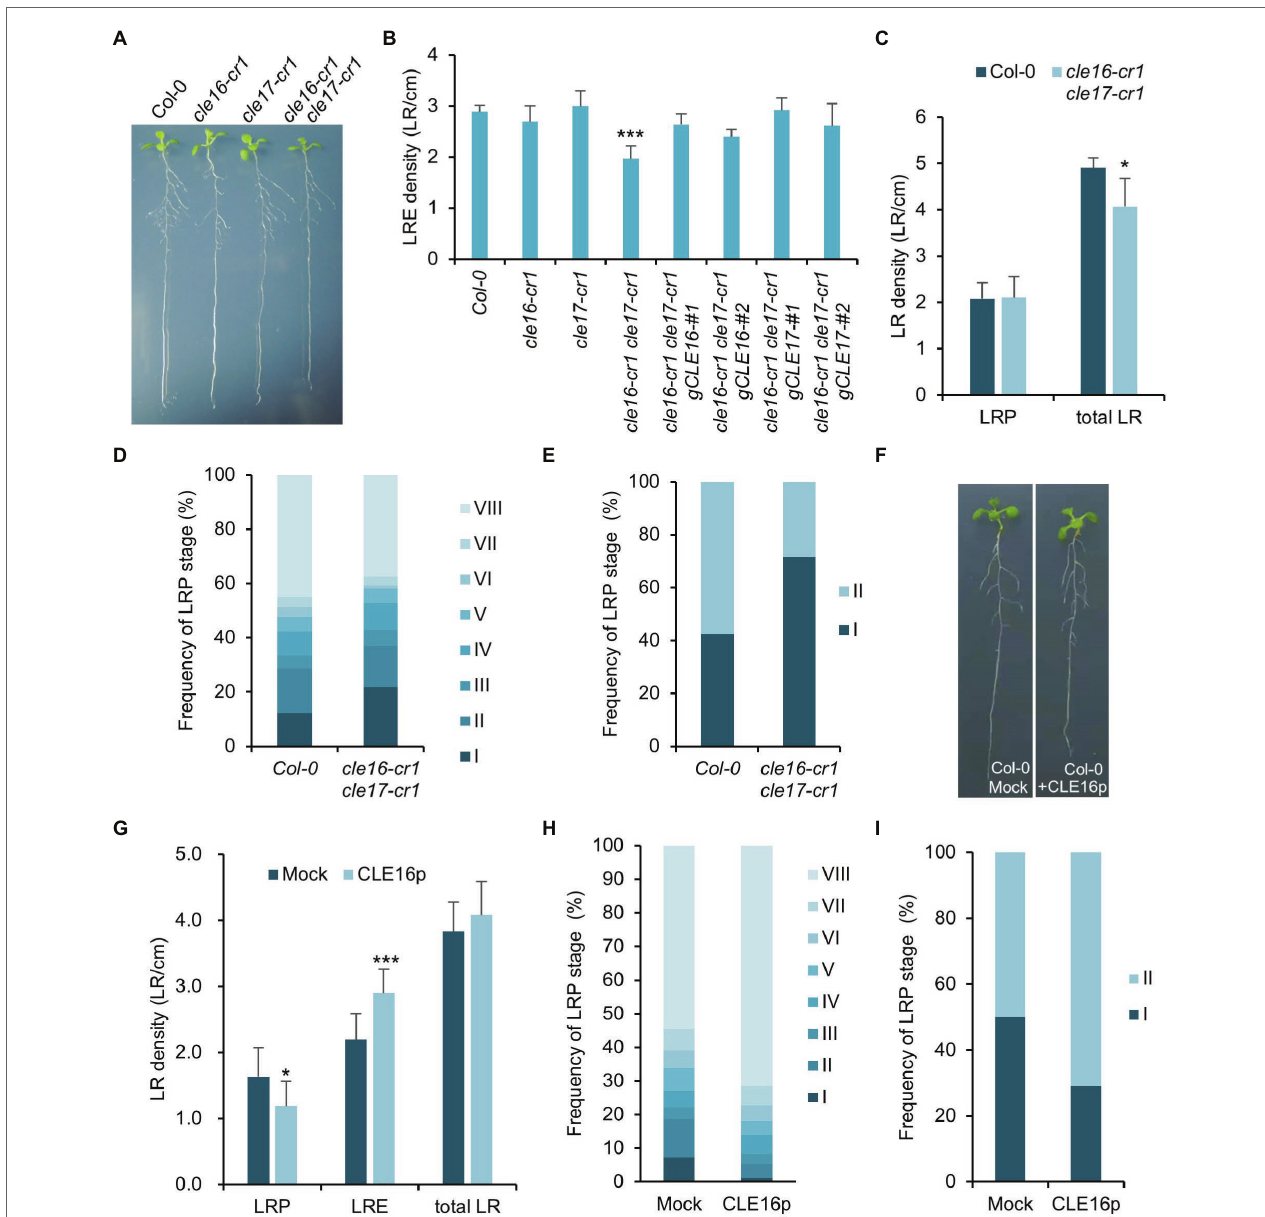
FIGURE 5 | CLE16/17 are required for lateral root emergence. (A) Phenotypes of the seedlings of cle16/17 double mutants at 8 dpg. (B) Quantification of lateral root emergence (LRE) density in the cle16/17 double mutants. n = 30 for each genotype. (C) LR primordia (LRP) and total LR (LRE + LRP) density of wild-type (Col-0) and cle16/17 at 8 dpg. n = 35 for each genotype. (D) Quantification of LRP at various stages in Col-0 and cle16/17 . Stages I–VIII are color-coded. n = 30 for each genotype. (E) Quantification of the initiated LRP at stage I or II in Col-0 and cle16/17 after primary root bending for 18 h. n = 30 for each genotype. (F) Seedlings of Col-0 at 8 dpg after mock or 1 μ M CLE16p treatment for 2 days. (G–I) Quantification of LRP, LRE, and total LR density in seedlings treated with or without 1 μ M CLE16p. (H) Quantification of individual primordia stages in seedlings treated with or without CLE16p. (I) Quantification of the initiated LRP at stage I or II in Col-0 treated with or without CLE16p after primary root bending for 18 h. n = 30 for each treatment. Error bars represent SD. Student’s t -test, * p < 0.05, ** p < 0.01, and *** p <